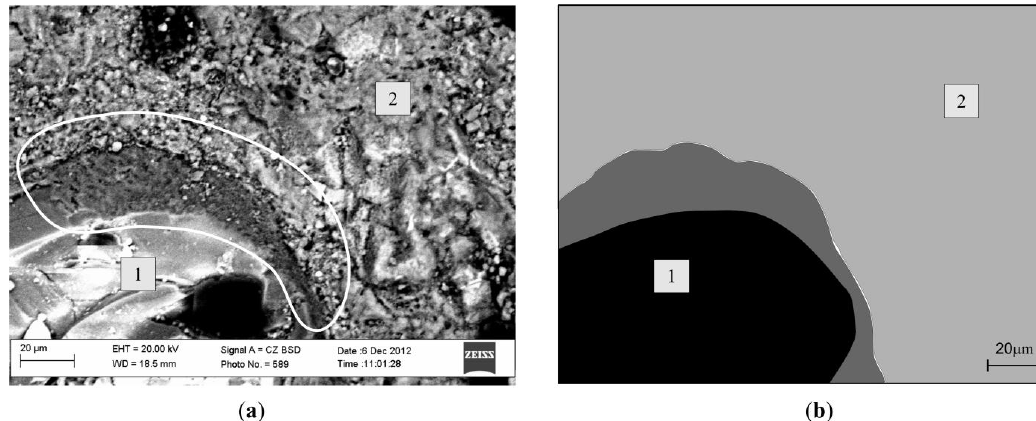
Figure 10. Contact area of new cement stone and concrete waste aggregate, ( a ) microscopic view; ( b ) view analyzed with computer graphic software; 1—aggregate obtained by crushing concrete waste; 2—new cement stone.